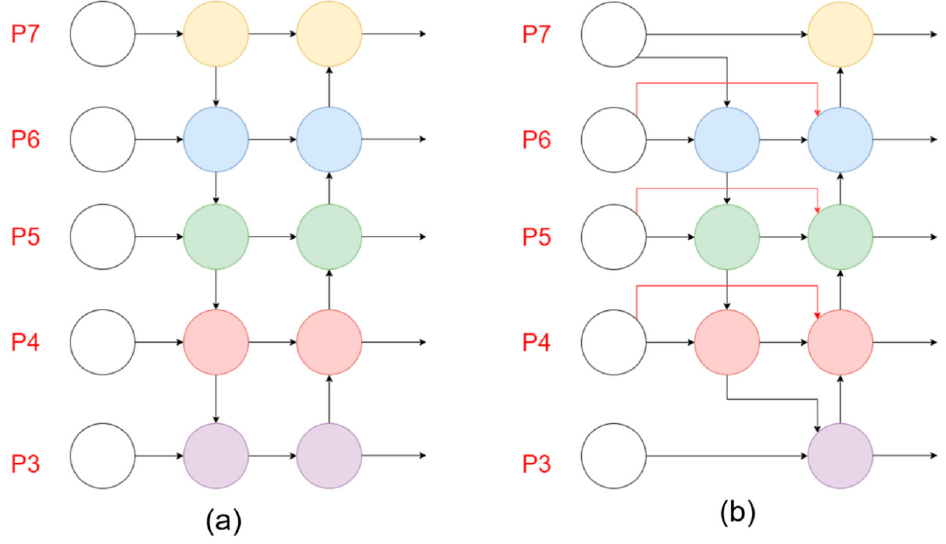
Figure 8. The structures of BiFPN and PANet. ( a ) PANet; ( b ) BiFPN.